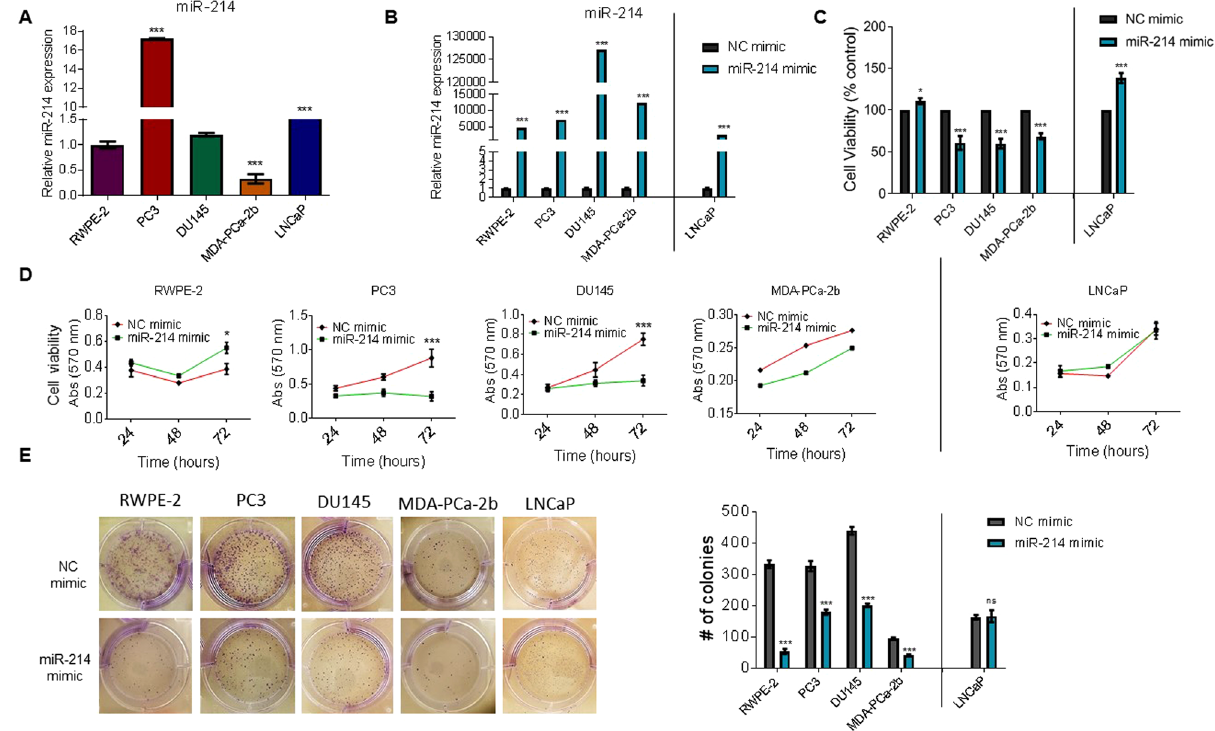
Figure 1. Effects of miR-214 on cell proliferation and colony formation in prostate cancer cells. ( A) RWPE-2, PC3, DU145, MDA-PCa-2b, and LNCaP cells were cultured for 30 h, and the relative endogenous expression of miR-214 was analyzed by RT/qPCR. (B) RWPE-2, PC3, DU145, MDA-PCa-2b cells, and LNCaP were transfected with negative control (NC) mimic miRNA or miR-214 mimic for 48 h. miR-214 expression levels were then determined by RT/qPCR. ( C ) RWPE-2, PC3, DU145, MDA-PCa-2b, and LNCaP cells were transfected with NC or miR-214 mimic. After 48 h, the effect of the miR-214 expression on cell viability was determined by MTT assay. ( D ) The time-dependent effects of miR-214 expression on cell viability were determined by MTT assay. ( E ) The effect of NC or miR-214 mimic on cell colony formation was determined by colony formation assay (left). The number of colonies were measured by ImageJ software. The data represent the colony count ± SEM (right). One-way and two-way ANOVA followed by Tukey’s multiple comparisons test were used to determine statistical significance for RT/qPCR and MTT assay, respectively. Results are representative of three independent experiments. * P < 0.05, ** P < 0.005, *** P < 0.0005 compared with NC- transfected